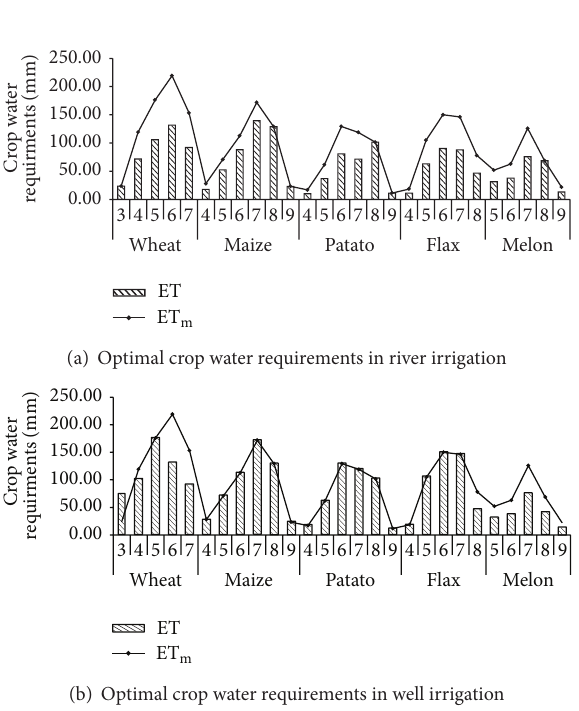
(b) Optimal crop water requirements in well irrigation Figure 4: Results of crop deficit irrigation